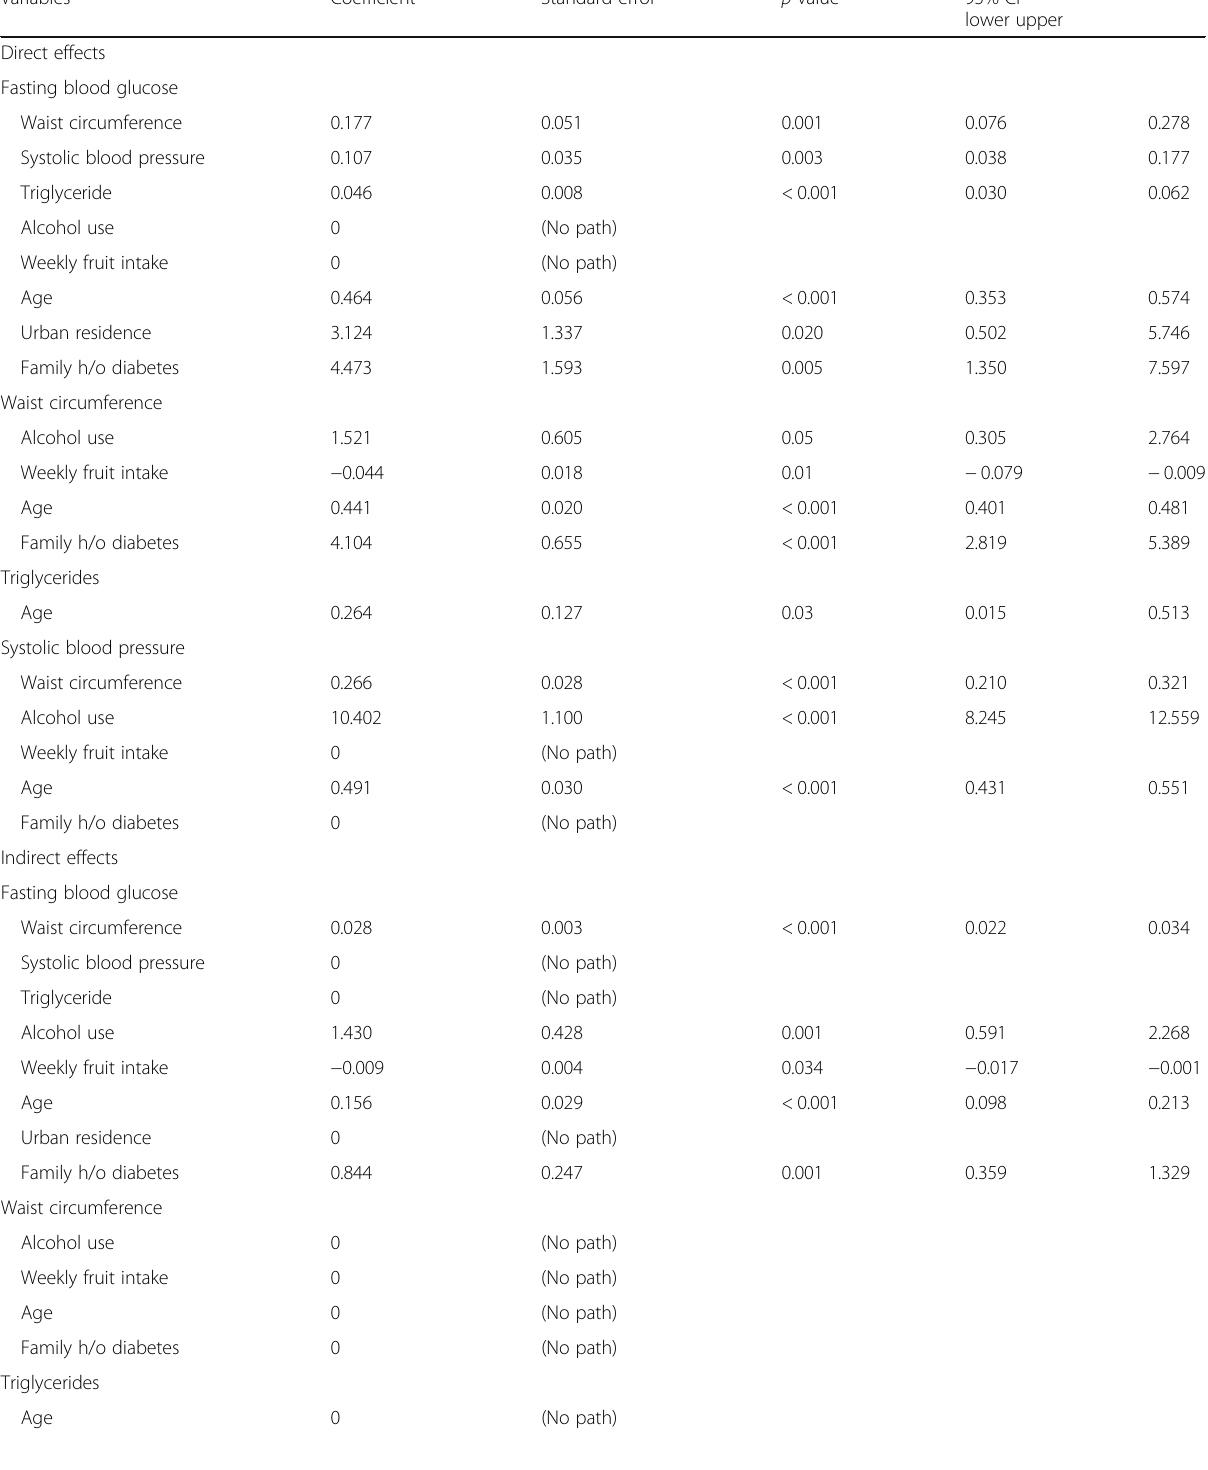
Table 2 Coefficient and standard error of the final SEM model of risk factors for diabetes in the STEPwise approach to